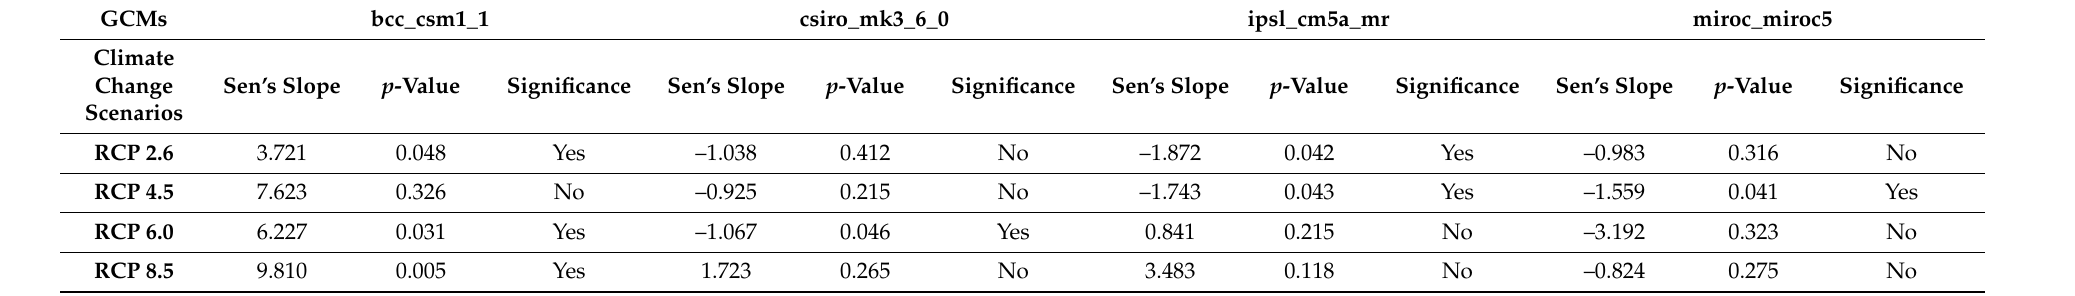
Table 1. Mann–Kendall trend test for precipitation (2020–2059) with all the four climate change scenarios.